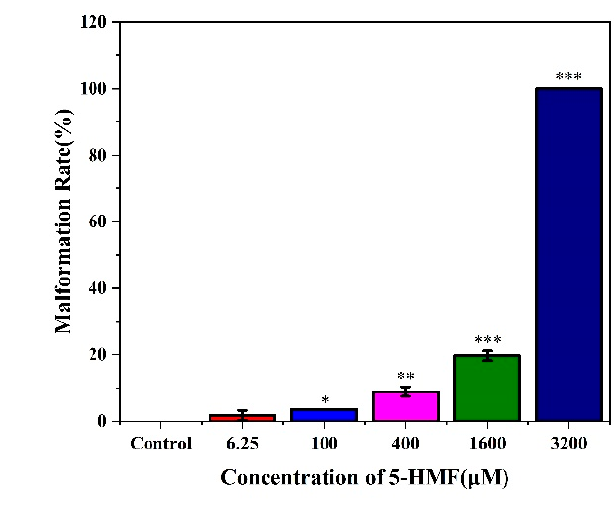
( d ) Figure 2. Developmental toxicity and teratogenicity of zebrafish larvae exposed to different concen- trations of 5-HMF for 120 h. ( a ) Death rate of zebrafish embryos treated with different concentrations of 5-HMF; ( b ) Malformation rate of zebrafish embryos treated with different concentrations of 5- HMF; ( c ) Malformation of zebrafish larvae treated with high concentrations of 5-HMF, abbrevia- tions: PE, pericardial edema; SB, spinal bending; YD, delayed absorption of yolk sac; ( d ) Body length of zebrafish larvae treated with different concentrations of 5-HMF. * p < 0.05, ** p < 0.01 and *** p < 0.001 vs. control. 3.3. Suitable Exposure Concentration of Milk Power Matrix In order to explore the tolerance of zebrafish embryos to milk power matrix, we set four concentrations of 0.01%, 0.1%, 0.5%, and 1%, and cultured 6 hpf zebrafish embryos for 120 h. At 48 h, zebrafish embryos could not survive normally in 0.5% and 1% milk matrix, while there was no significant difference in survival rate at other concentrations (Figure 3a). Zebrafish embryos could hatch faster in 0.01% and 0.1% milk matrix with a hatching rate of 100% in 48 h, while the control group could not hatch completely until 72 h (Figure 3b). Compared with the control group, the morphology and body length of zebrafish larvae in the 0.01% concentration group were not significantly different, while 0.1% showed delayed absorption of yolk sac and shorter body length (Figure 3c,d). In order to avoid affecting the normal development of zebrafish embryos due to the discom- fort of milk powder matrix concentration, we chose 0.01% milk powder matrix for follow- up experiments.